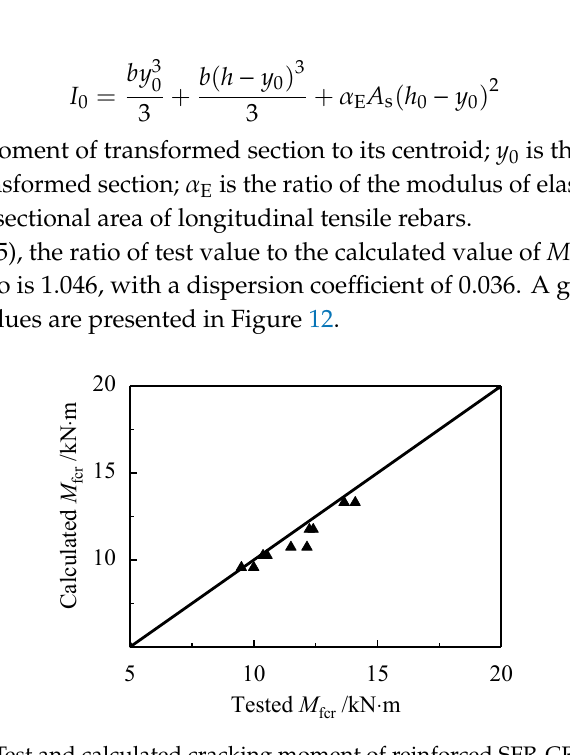
( b ) Figure 13. Ratio of tested to calculated values: ( a ) average crack width; ( b ) maximum crack width.